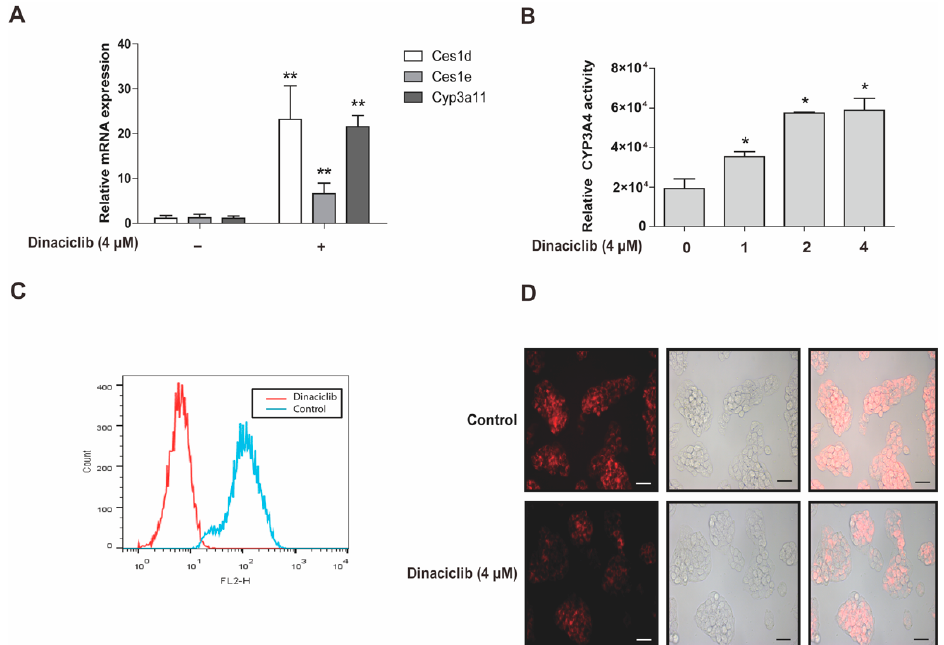
Figure 5. CDK2 inhibitor dinaciclib increases the expression and activity of PXR target genes. ( A ) Primary mouse hepatocytes were treated with dinaciclib (4 μ M) for 24 h, and the gene expression was analyzed at mRNA levels. ( B ) Dinaciclib promoted the oxidative activity of CYP3A4. HepG2 cells were treated with dinaciclib (0, 1, 2 or 4 μ M) for 24 h, and cell lysates were prepared and assayed for CYP3A4 activity. ( C,D ) Dinaciclib promoted the efflux activity of P-gp. HepG2 cells were treated with or without dinaciclib (4 μ M) for 24 h, then incubated with DMEM (10% FBS) supplemented with 5 μ g·mL − 1 Rho 123 for 30 min. The efflux activity of P-gp was analyzed immediately by flow cytometry ( C ) or observed under a fluorescence microscope ( D ). Scale bar: 50 μ m. Experiments described in this figure were repeated independently at least three times, and data are expressed as mean ± SEM ( n = 3). * p < 0.05 and ** p < 0.01 indicates significant difference compared with control group.